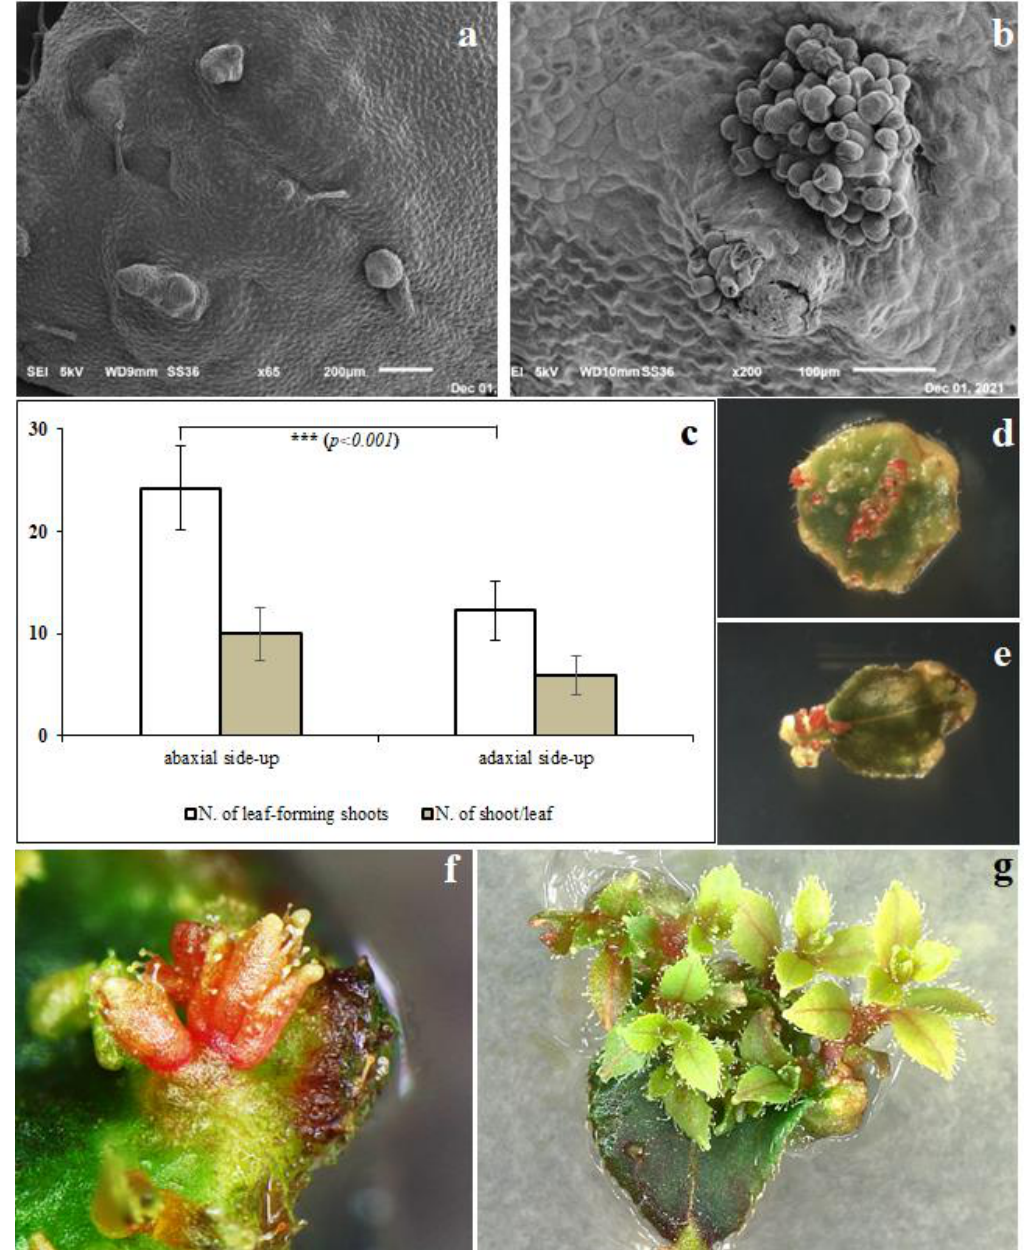
Figure 1. ( a ) Leaf tissues observed under a scanning electron microscope (SEM) after 5 days in culture medium with evidence of single or ( b ) grouped bud primordia. ( c ) Effect of explant orientations (abaxial or adaxial side up) on in vitro shoot organogenesis in “M5” highbush blueberry. De novo shoot organogenesis on the leaf surface closer to the vein ( d ) or to the petiole ( e ). First organogenesis from mutagen-free medium ( f ) and developed adventitious shoots ( g ).